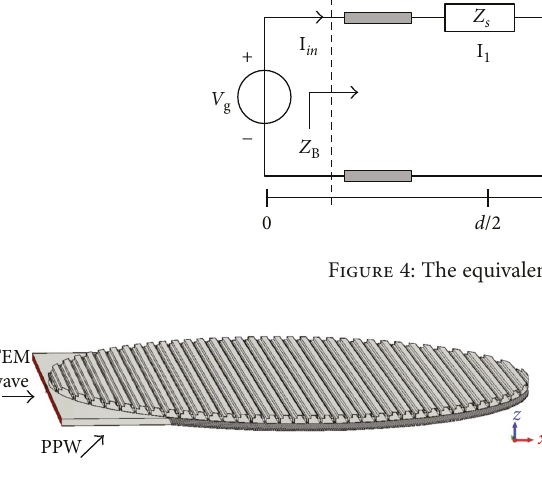
Figure 5: Prototype of 700 mm circular-aperture VICTS antenna. Based on the periodic element shown in Figure 3.